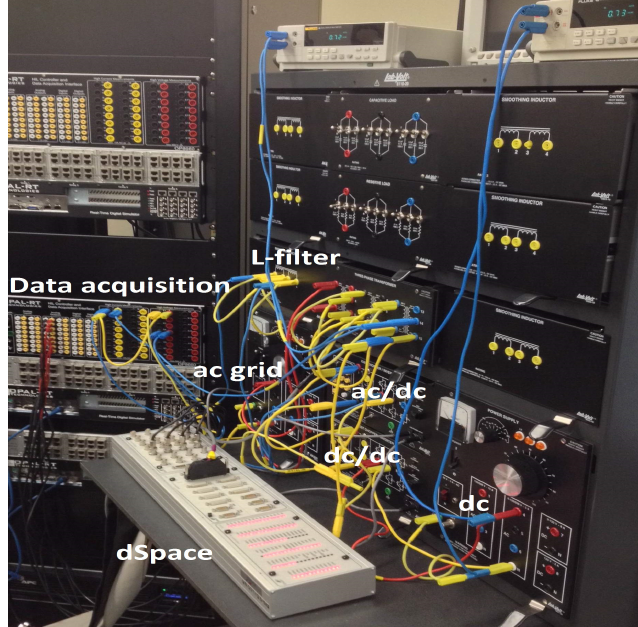
Figure 15. The hardware experiment testing